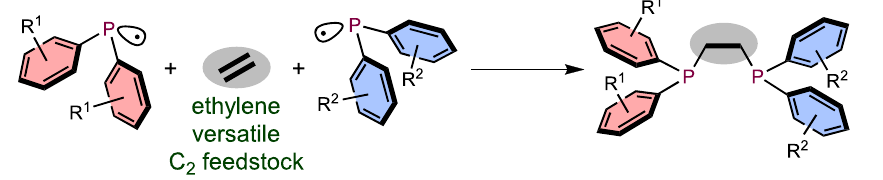
electron-withdrawing group. d The synthesis of DPPEs from ethylene and two phosphine-centered